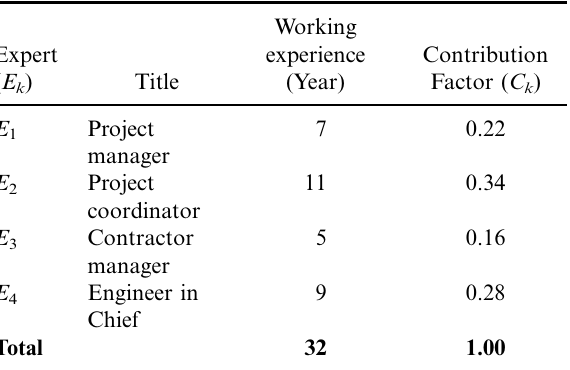
Table 4. Experts and their respective contribution factors in the model Pilot Run